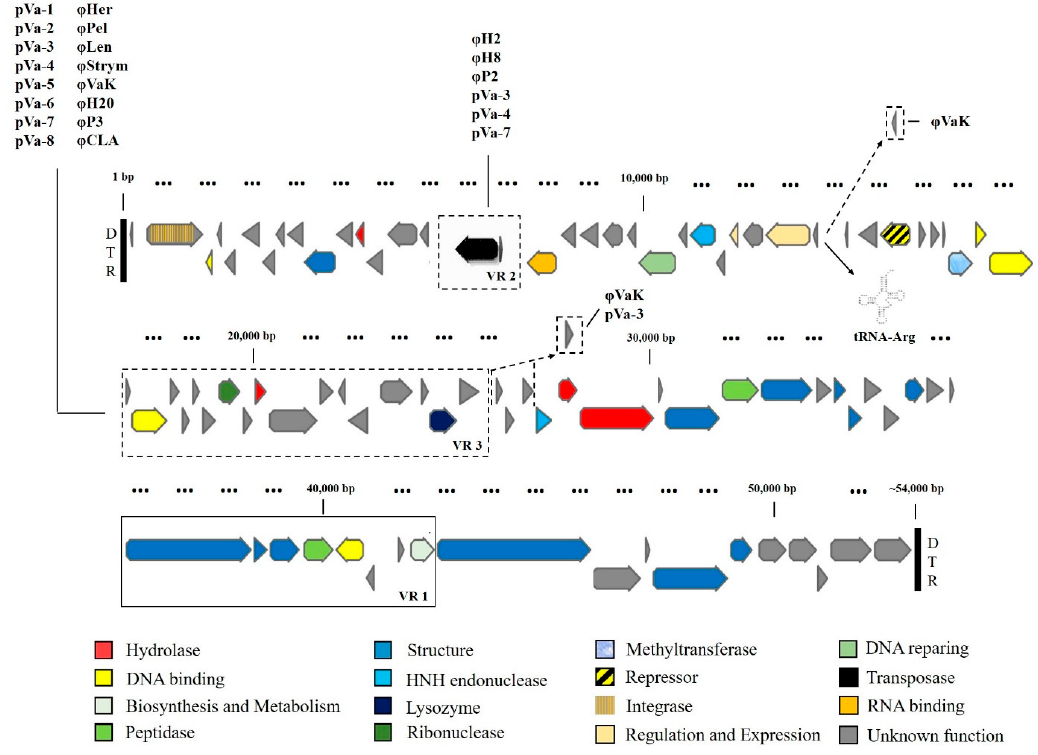
Figure 4 . The core ‐ and accessory ‐ gene content of the H20 ‐ like bacteriophages. Core ‐ gene content is composed by 74 genes shared by all 19 bacteriophages. Accessory ‐ gene content is indicated by dashed lines, with VR1 and VR2 representing the main components. The bacteriophages that contain the accessory gene blocks VR1 and/or VR2 are correspondingly indicated in columns beside. Two more hypothetical proteins complement the accessory gene content and their corresponding carrier phages (pVa ‐ 3 and φ VaK) are also indicated. DTRs mark the physical ends of the genome (bold vertical lines). In the case of φ VaK, VR2 and VR3 are the most diverse compared to the other homogenous phage genomes. However, the vast majority of the changes are silent and do not translate into any differences in the predicted gene function at the amino acid